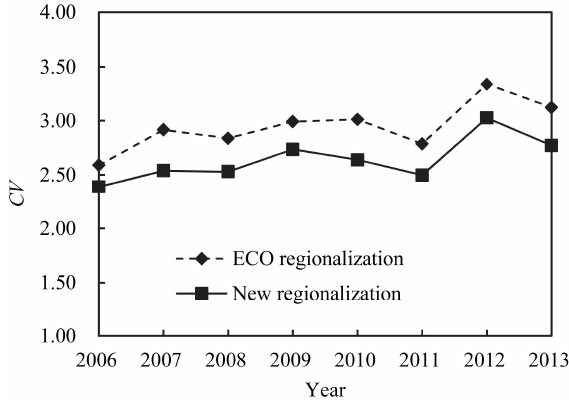
Figure 6. The coefficient of variation of net primary productivity values for the new regionalization scheme and the Chinese eco-geographical regionalization (ECO regionalization) scheme in different years.